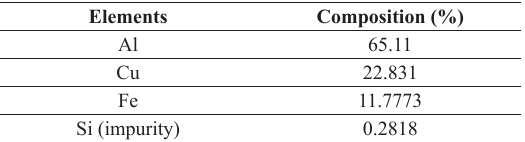
Table 1. Alloy elements of the AlCuFe and its respective